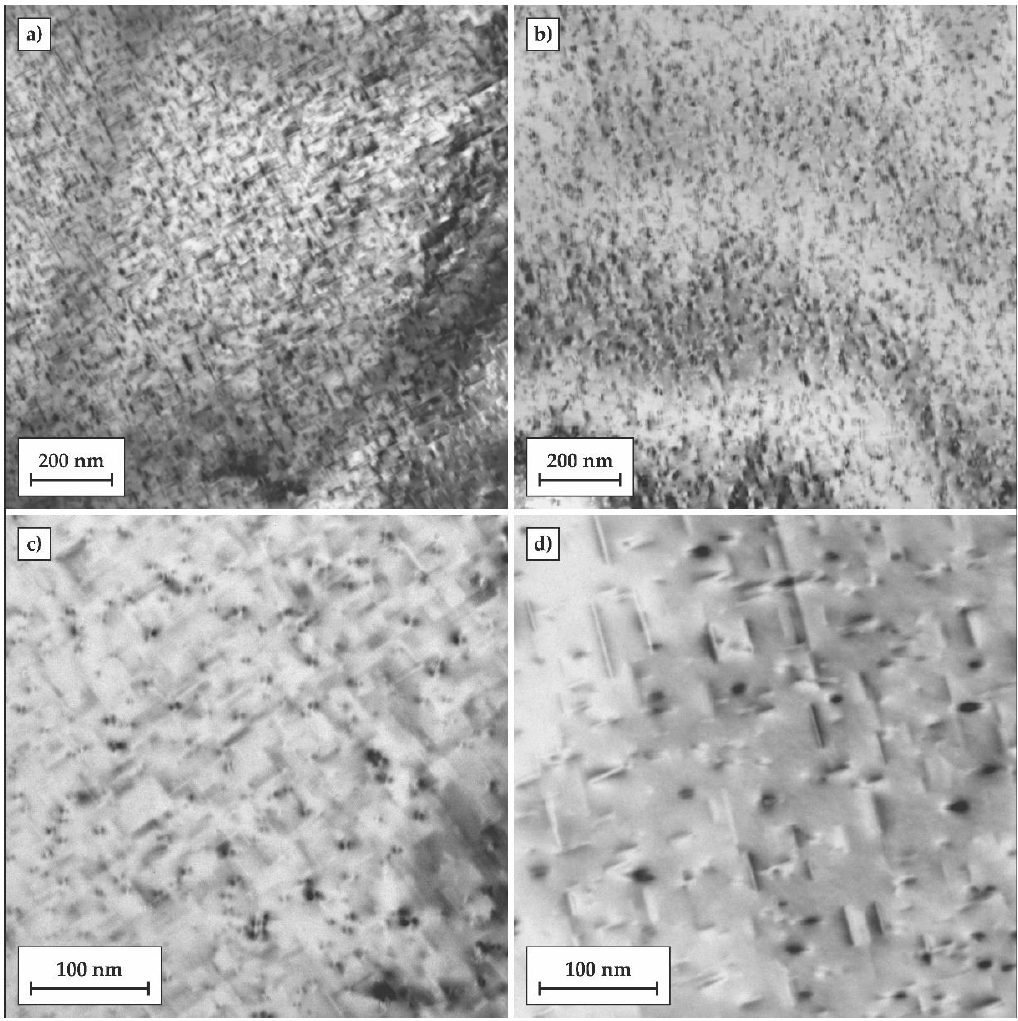
Figure 8. TEM micrographs showing the matrix precipitation of the alloy after two investigated heat treatment procedures: ( a , c ) conventional heat treatment to the T6 temper including artificial ageing at 170°C for 24 h; ( b , d ) quenched directly to the temperature of 170 °C followed by 24 h of artificial ageing (T6DA).